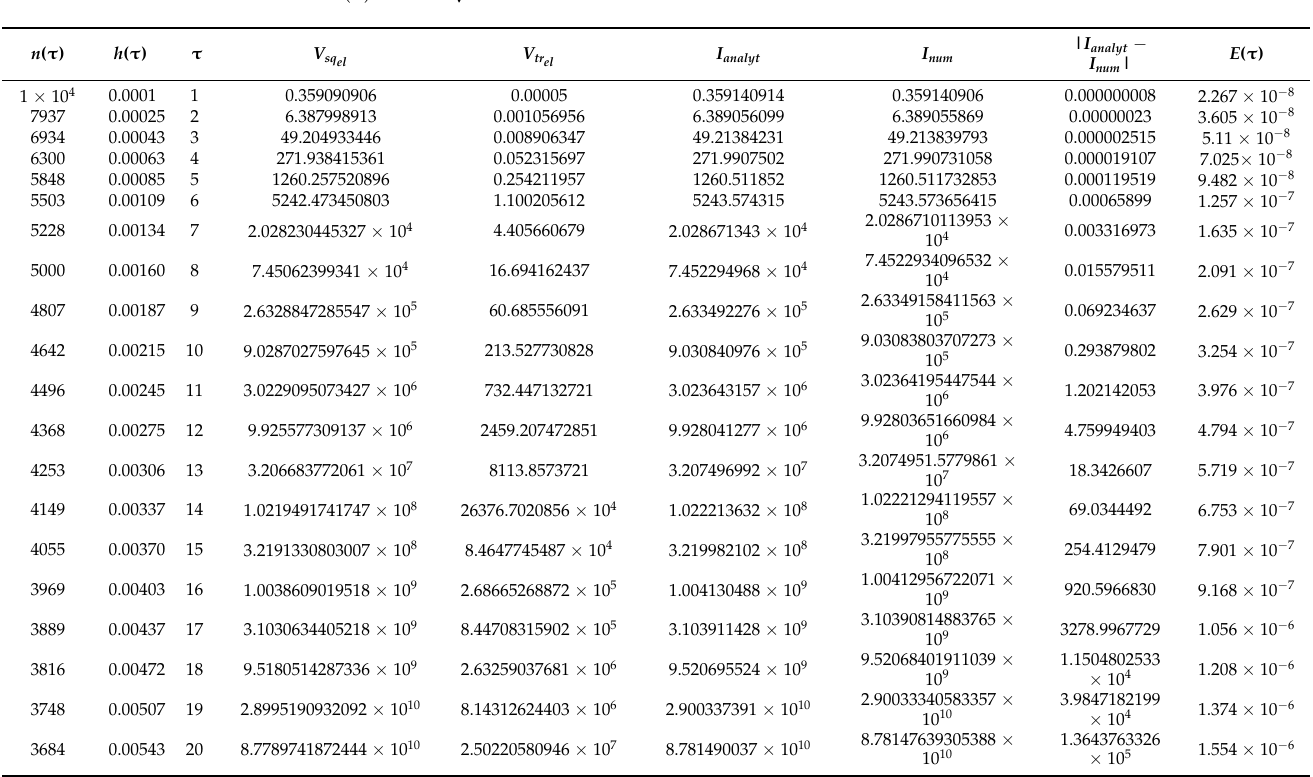
Table 8. Calculation of integral